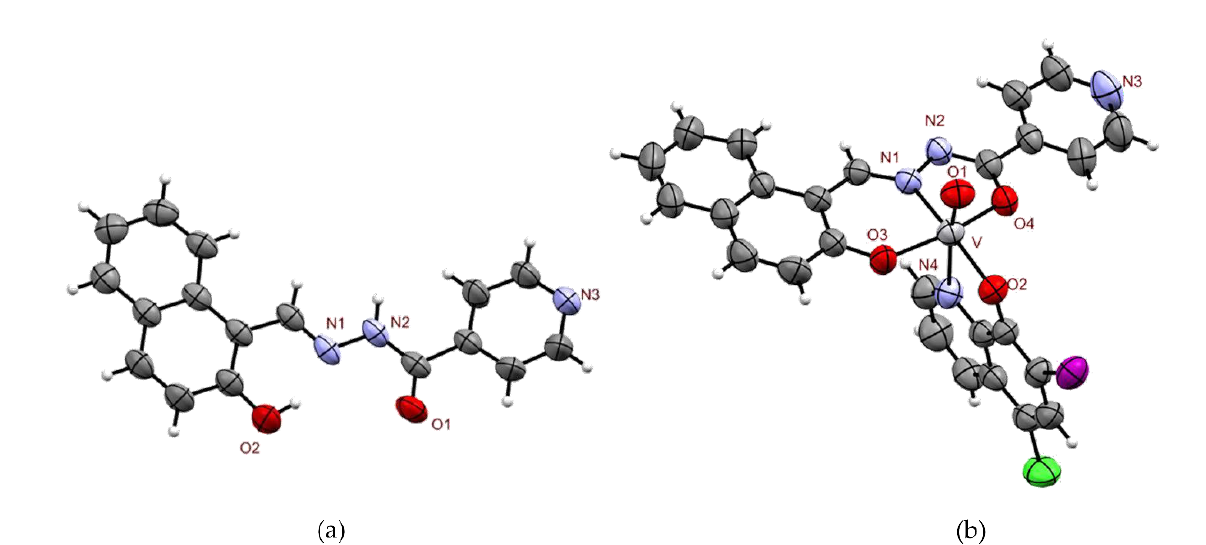
Figure 2. ORTEP drawing depicting a view of: ( a ) IN free ligand; ( b ) [V V O(IN-2H)(L2-H)] · 1.5 THF showing the labeling of the O and N atoms and the displacement ellipsoids at the 50% probability level (solvent molecules were removed to clarify the visualization).